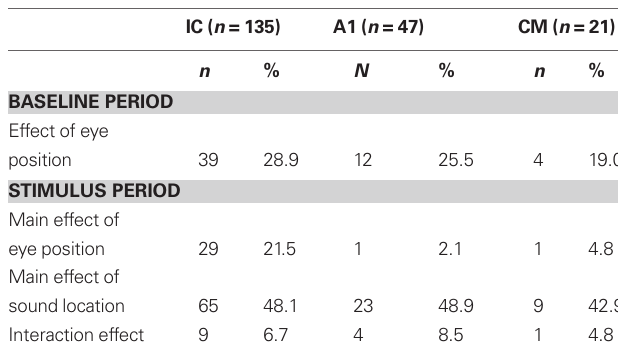
Table 1 | Statistical analysis of eye position sensitivity using ANOVA ( α =